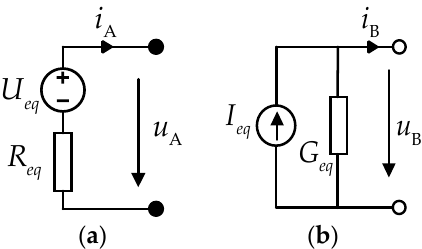
Figure 6. Illustration of the Thevenin/Norton equivalent: ( a ) Thevenin circuit; ( b ) Norton circuit.